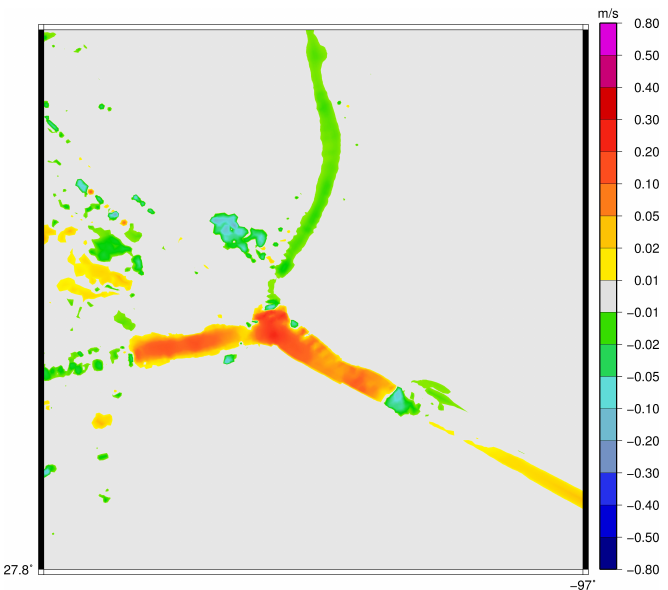
Figure 14. Difference in maximum velocity component for the extreme inflow scenario.